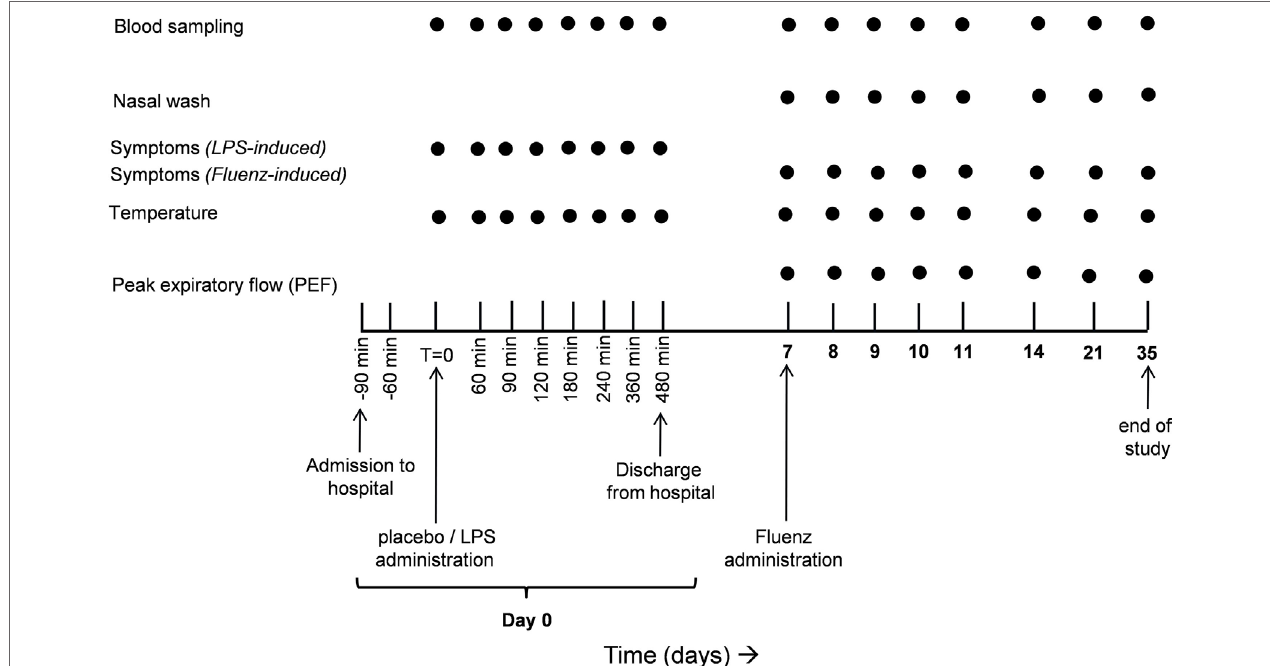
FigUre 1 | Experimental